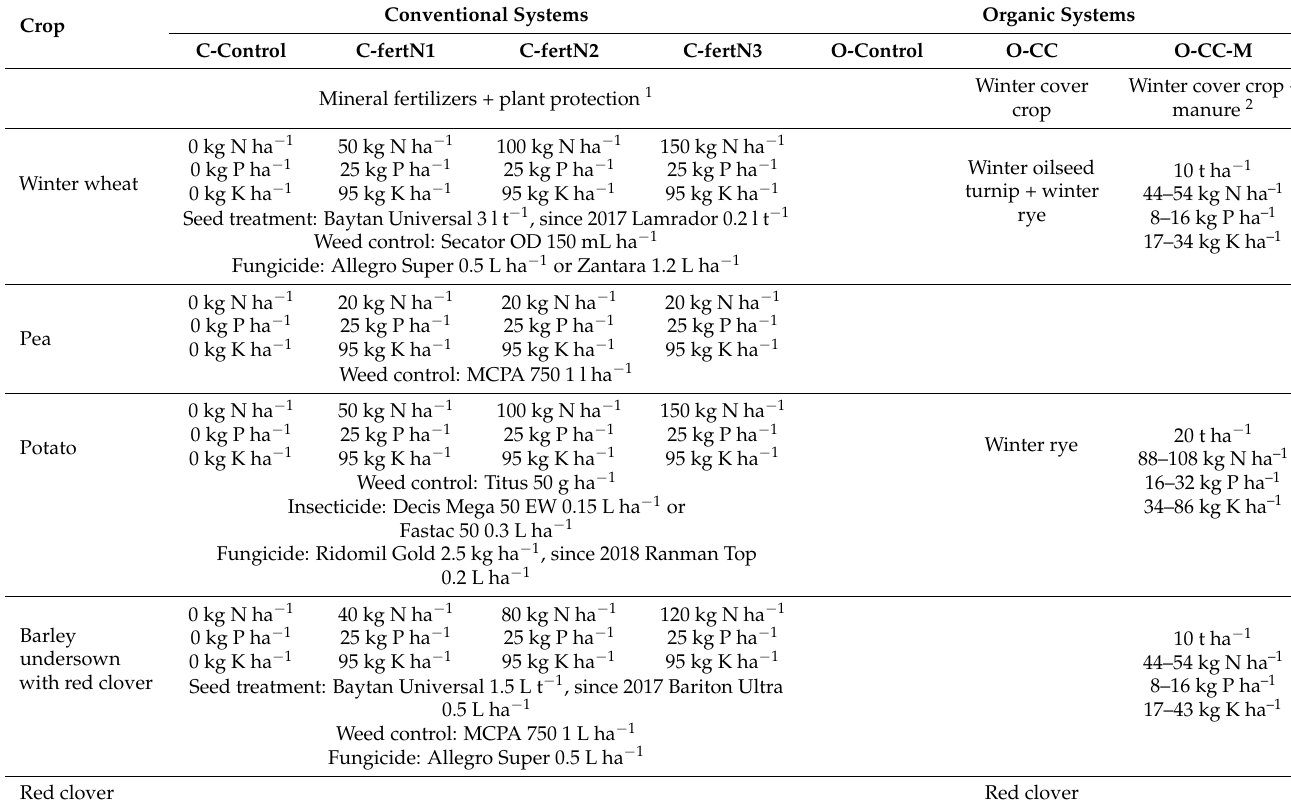
Table 1. The treatments in the organic and conventional farming